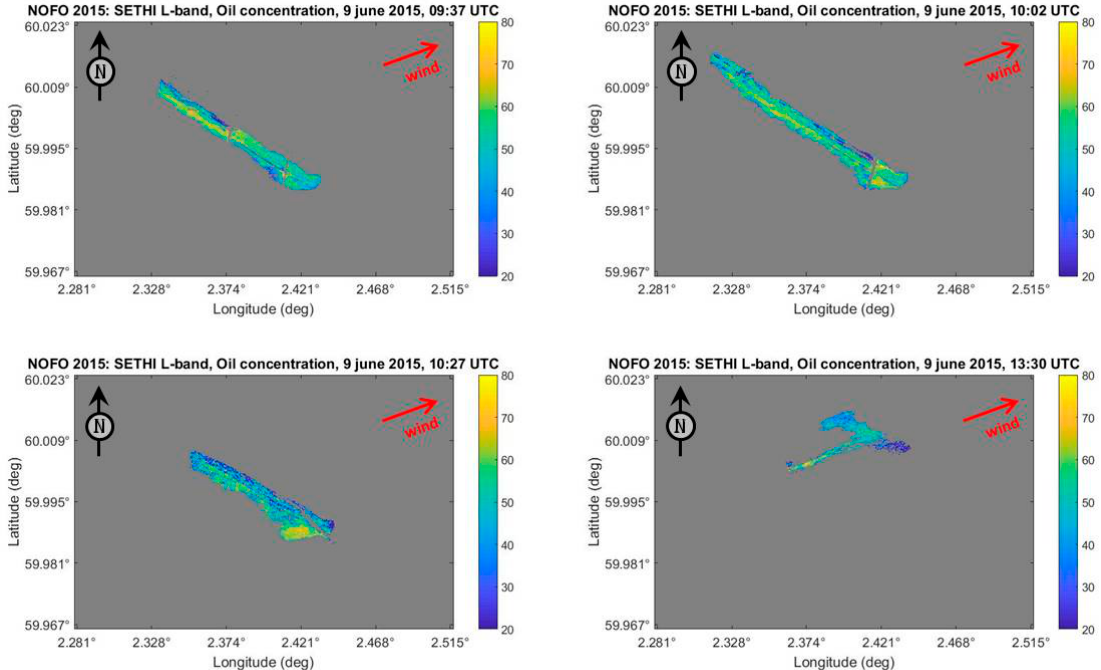
Figure 12. SETHI NOFO’2015 oil concentration map [20 80%] corresponding to the SAR data collected at 09:37 UTC (run 1—upper left panel), 10:02 UTC (run 2—upper right panel), 10:27 UTC (run 3—lower left panel) and 13:30 UTC (run 4—lower right panel)—multi-look 21 × 21—ground geometry.